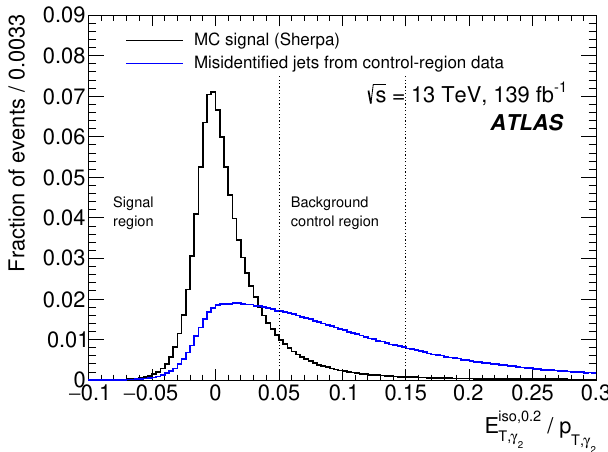
Figure 2. Relative photon isolation distribution for the sub-leading photon candidate as extracted from the Sherpa diphoton sample (black histogram), and from misidentified jets, estimated from data events with sub-leading photon candidates failing the tight identification requirement (blue histogram). A small prompt-photon contribution to the non-tight control region is subtracted from the blue histogram, according to the Sherpa sample predictions.